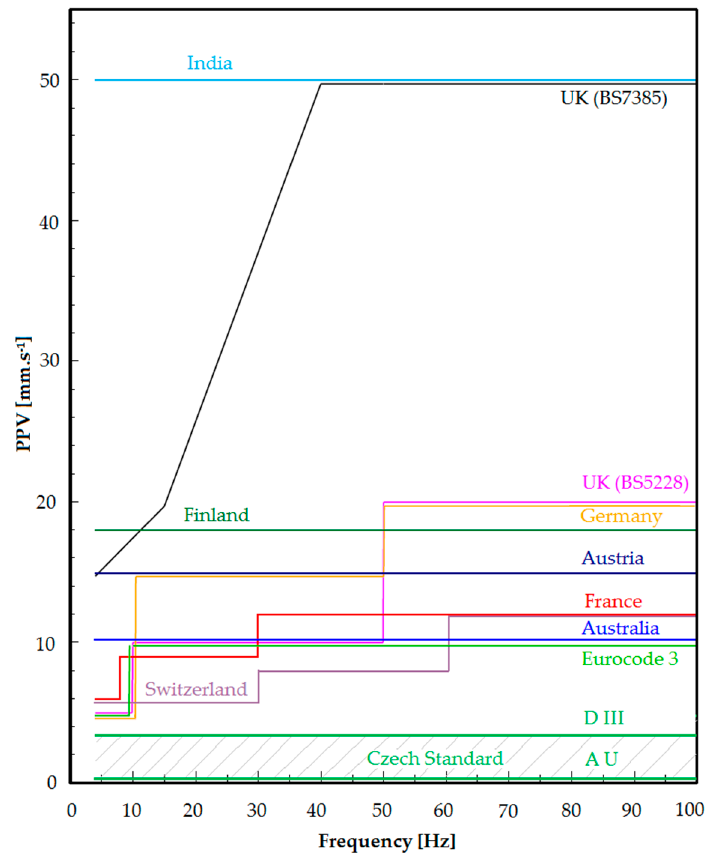
Figure 13. Summary of limit values for vibration on residential buildings [40], Copyright SAGE Publications,